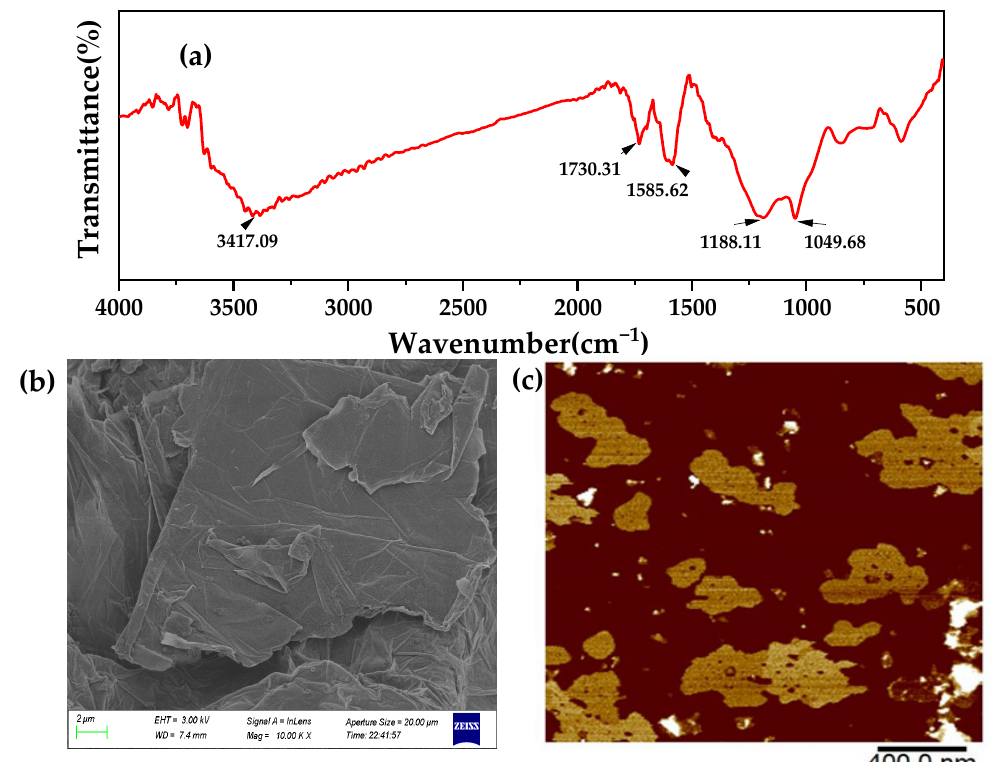
Figure 4. FTIR ( a ) spectra of the GO nanoparticles; SEM image of the GO ( b ); AFM image of the GO ( c ).